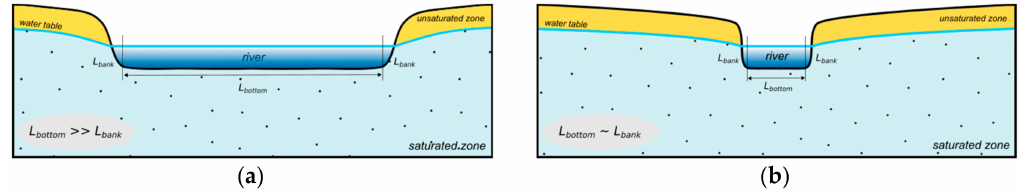
Figure 1. Cross section through di ff erent shapes of riverbed: ( a ) L bott >> L bank ; and ( b ) L bott ≈ L bank.